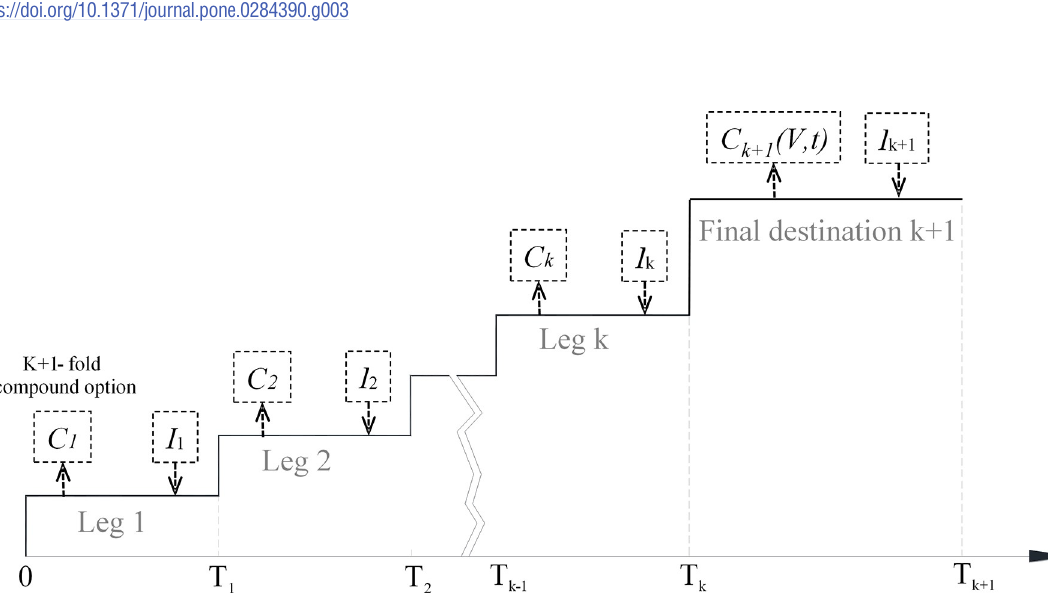
PLOS ONE | https://doi.org/10.1371/journal.pone.0284390 April 20, 2023 8 /